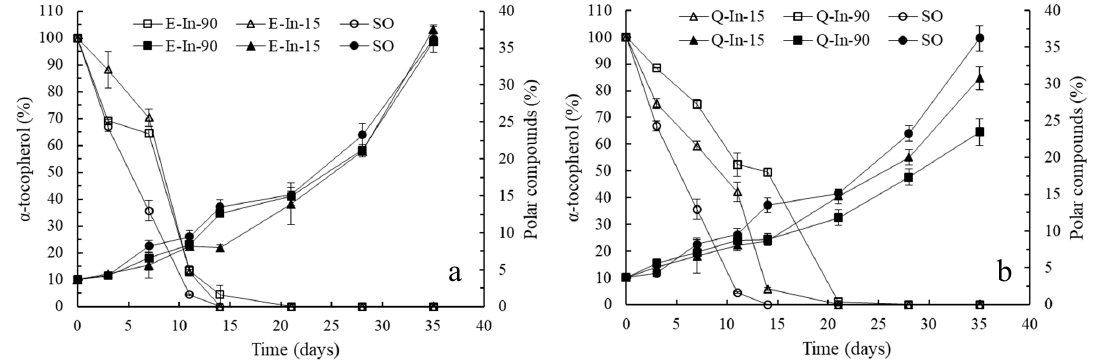
Figure 4. Evolution of polar compounds formation and α -tocopherol loss for SO and SO with flavonoid microparticles (a: E-In-15 and E-In-90; b: Q-In-15 and Q-In-90).